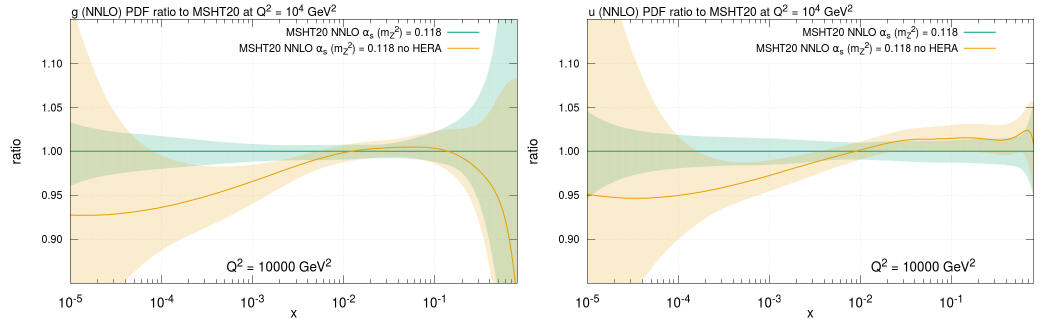
Figure 3: PDFs with and without inclusion of HERA data for gluon (left) and up quark (right).